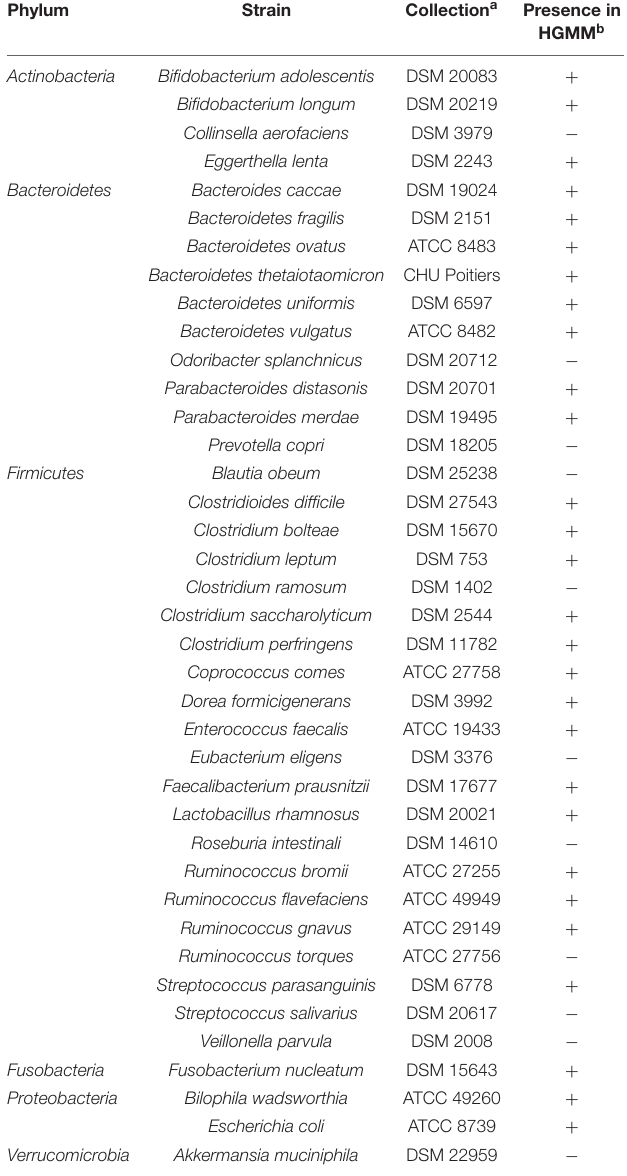
TABLE 1 | List of the bacterial strains selected from the literature to construct the human gut microbiota model. Phylum Strain Collection a Presence in